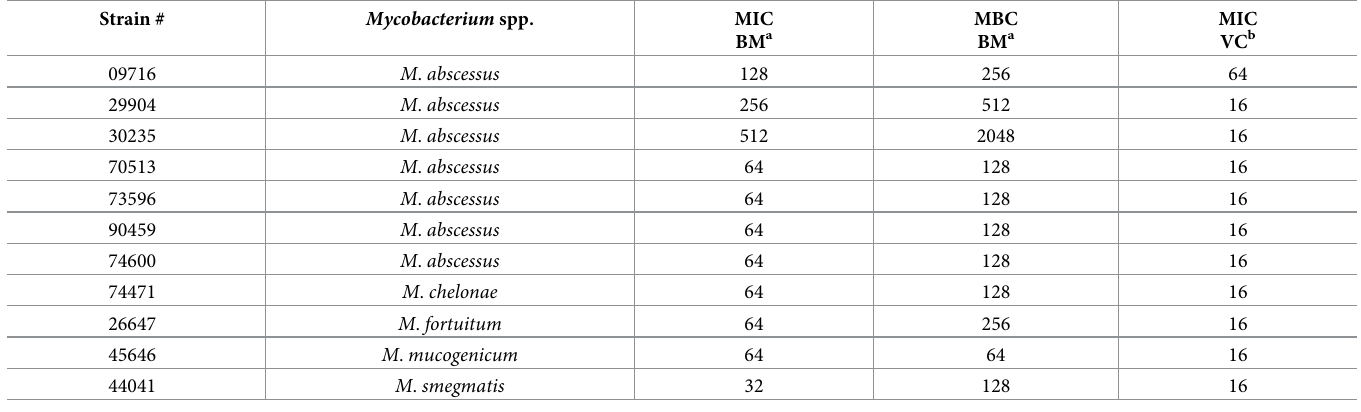
Table 2. Antibacterial activity of CAR, in liquid and vapour phase, against RGM strains. Strain # Mycobacterium